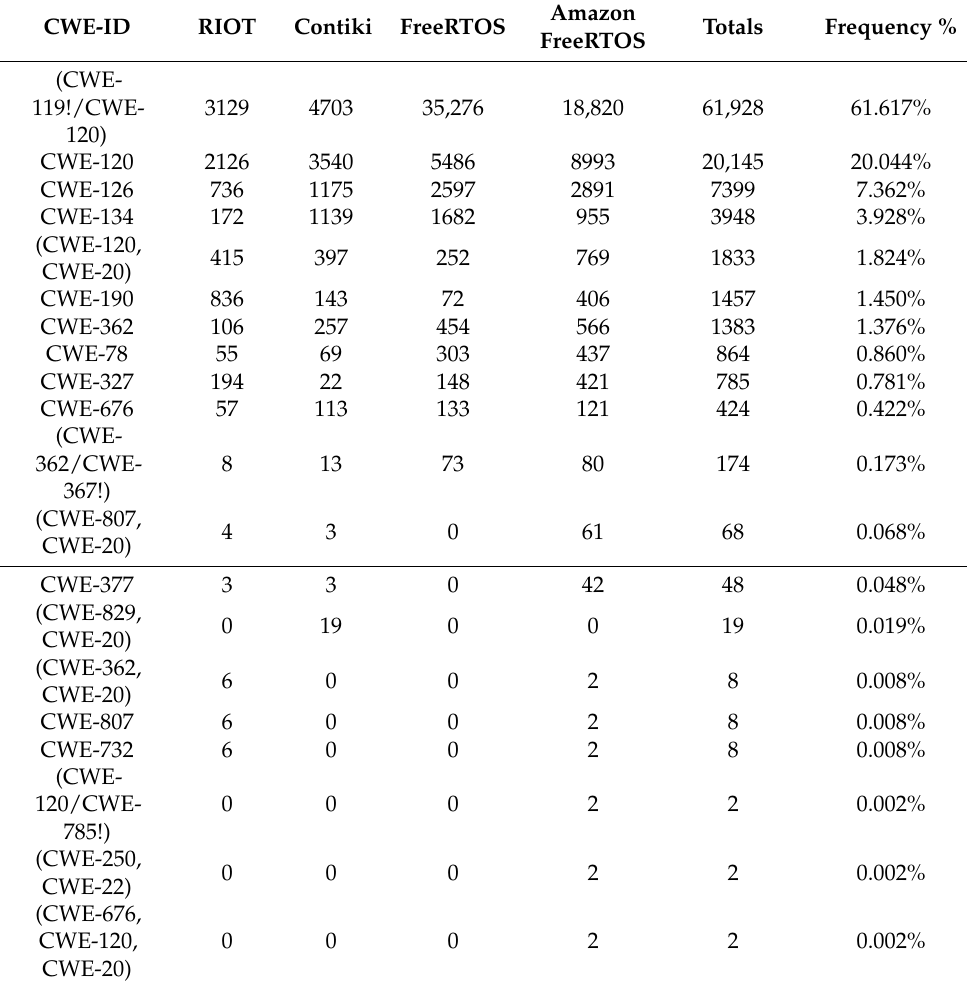
Table 9. Total CWEs of IoT OSs by Flawfinder 2.0.11.